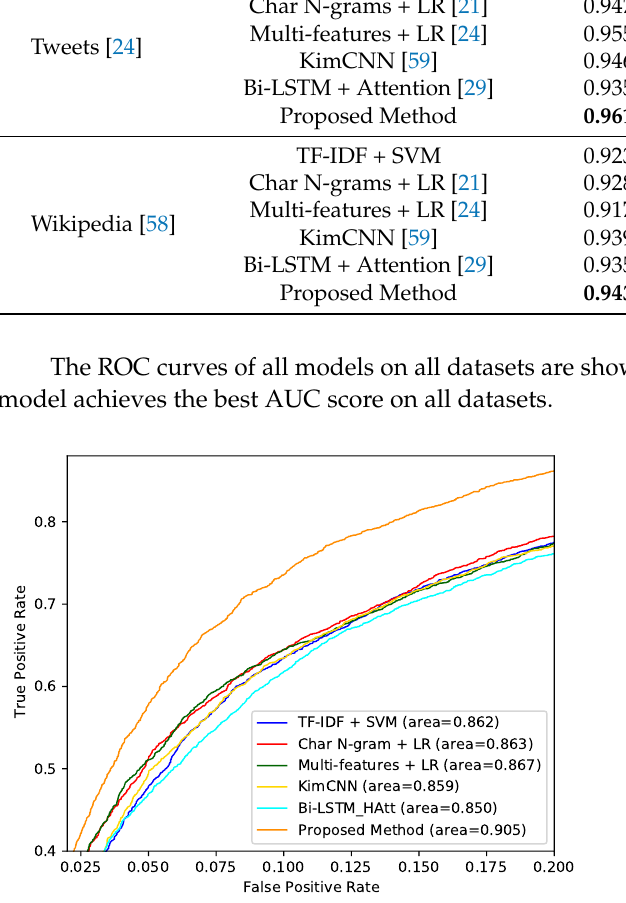
Figure 3. The ROC curve of dataset Tweets